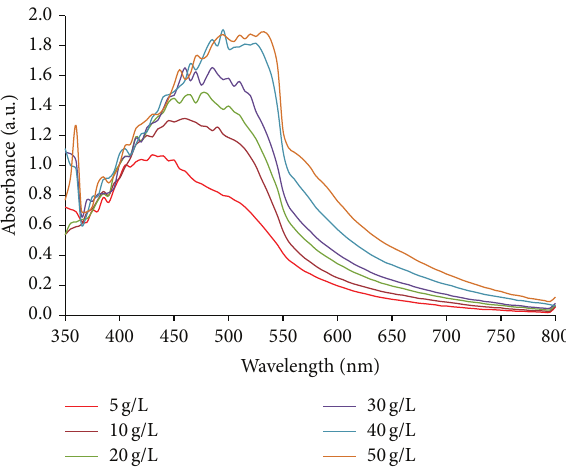
Figure 1: Effect of extract pH on AgNPs synthesis. Synthesis con- ditions: silver nitrate concentration, 1mM; extract concentration; 40 g/L, temperature, 45 ∘ C.